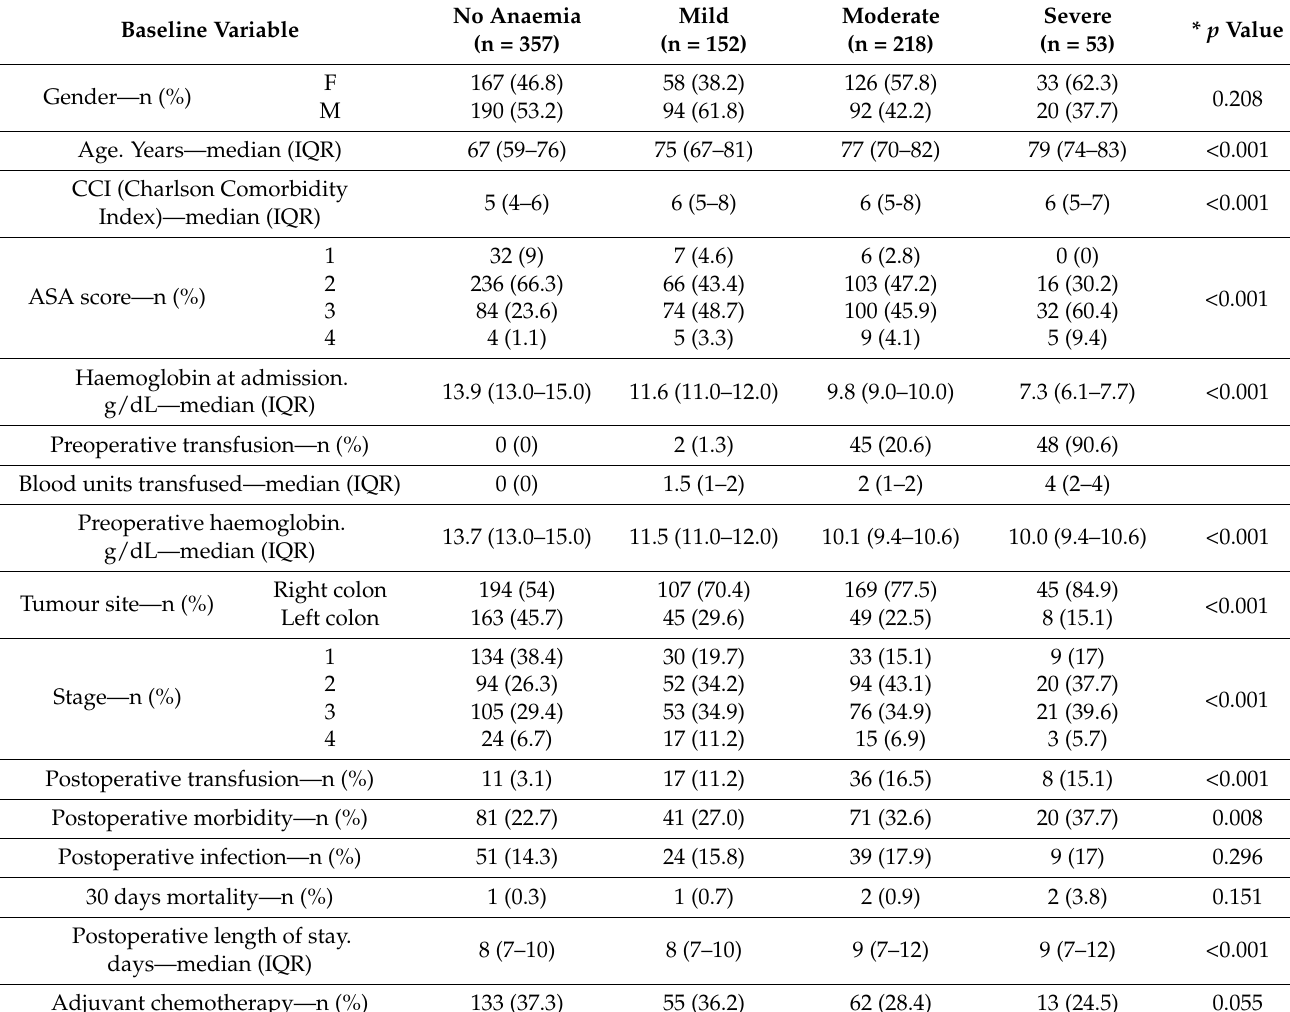
Figure 1. Summary of patients selection. Table 1. Baseline characteristics of study population according to anaemia severity.